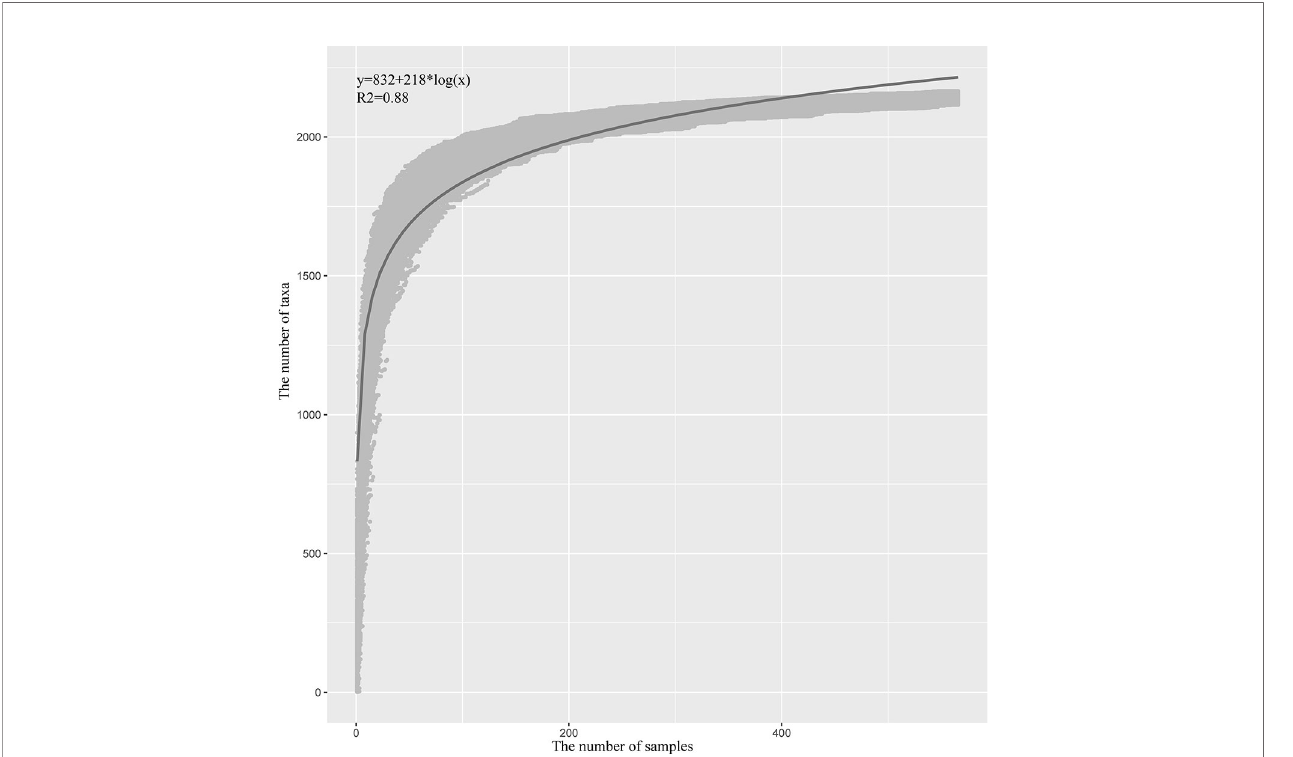
FIGURE 5 | Statistic estimation of the size of pan-microbiome in PDAC tissue. The x-axis is the number of samples, and the y-axis is the cumulative number of taxa. The process is brie fl y described as follows: One sample is randomly selected at a time, and the cumulative number of taxa is counted until 582 samples are obtained; then the process is repeated 1,000 times. All the data points are indicated in gray, and the blue line is the fi tted curve. The fi tting formula and R2 value are labeled at the top-left